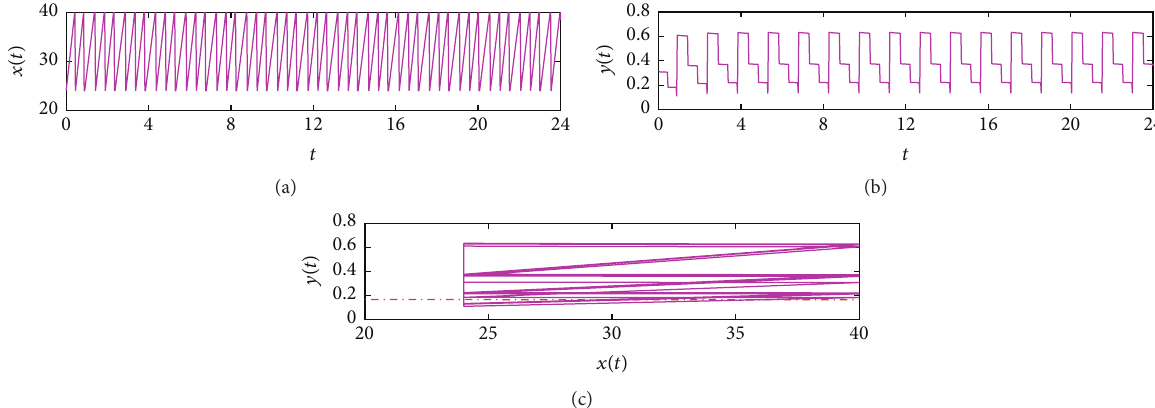
Figure 6: The change in prey density (a), predator density (b), and phase diagrams (c) starting from (𝑥 0 , 𝑦 0 ) = (24, 0.25) with 𝑝 = 0.4 , 𝑞 = 0.4 , = 20 , ℎ = 40 , 𝑦 (ℎ ) = 0.1664 , 𝑦 ((1 − 𝑝)ℎ ) = 0.1651 , and 𝛼 ℎ 1 2 𝜏 1 𝜏 2